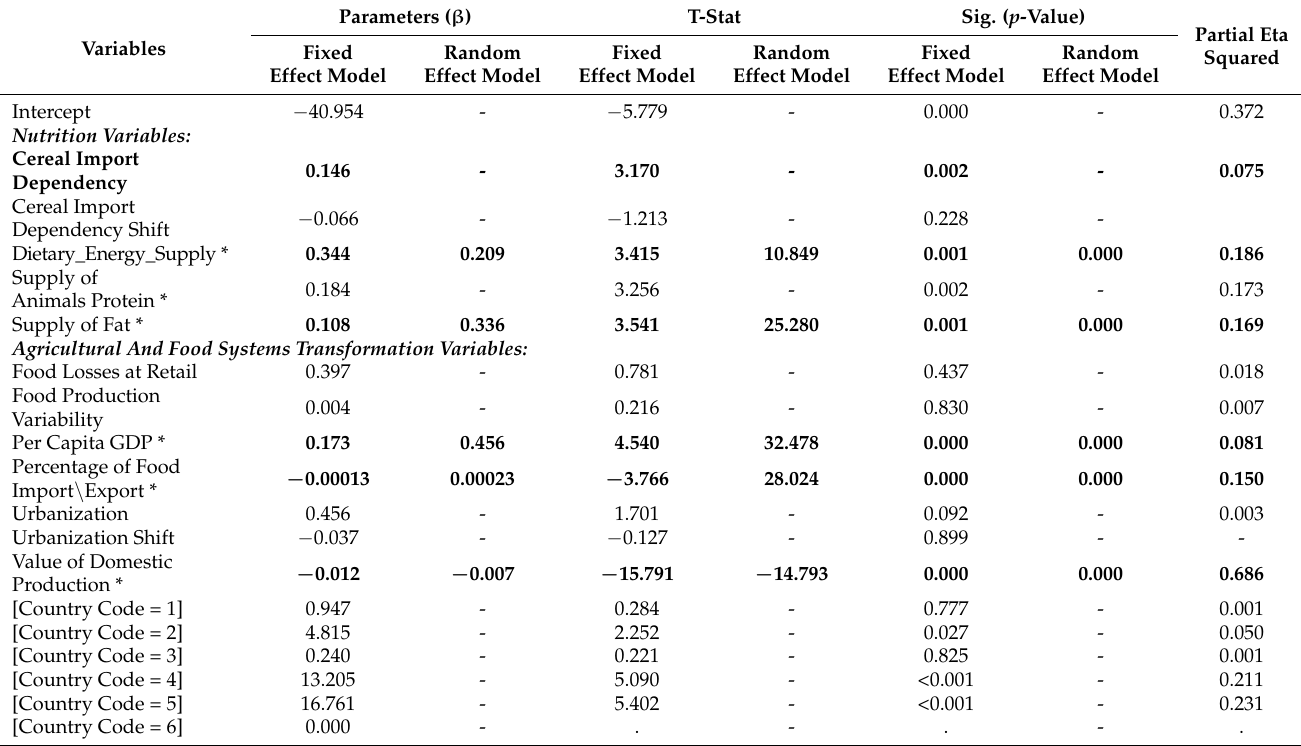
Table 7. Parameter estimates of obesity using fixed- and random-effect models results.